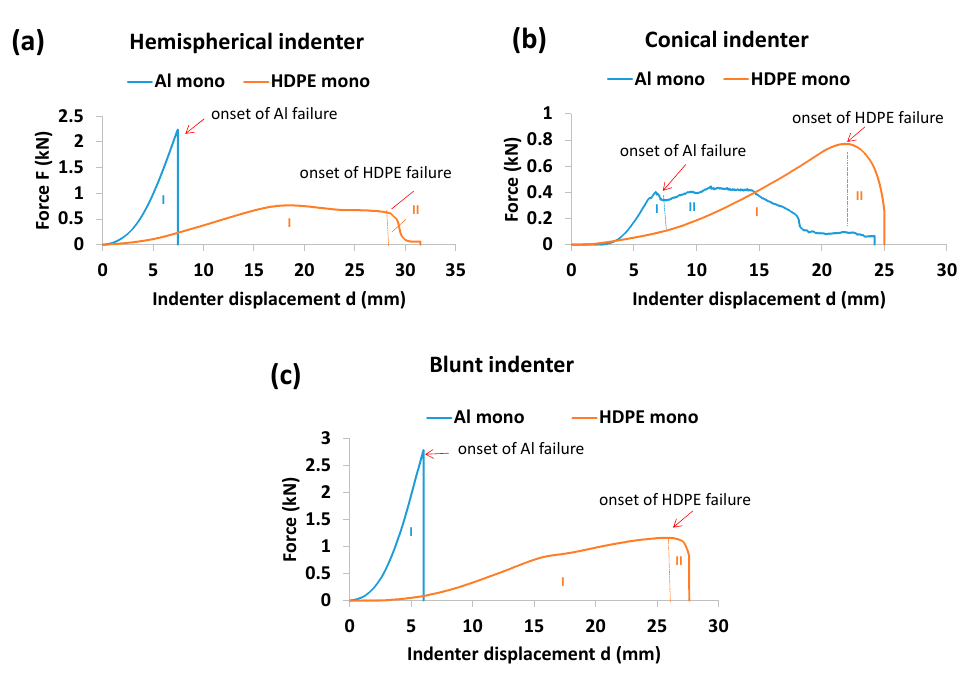
Figure 3. Indenter force and displacement profiles for monolithic aluminium and HDPE when they were perforated by ( a ) hemispherical, ( b ) conical and ( c ) blunt indenters. It can be seen from Figure 3 that the blunt indenter showed a higher gradient of force with respect to displacement, as compared with the hemispherical and conical